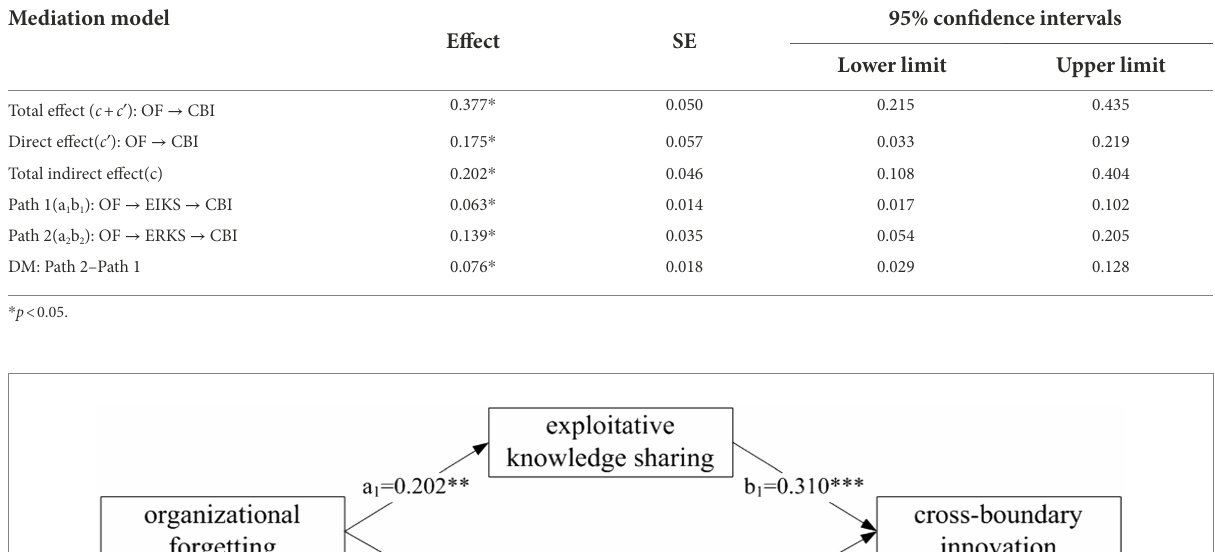
TABLE 6 Bootstrap analysis for significance test of mediation effect.